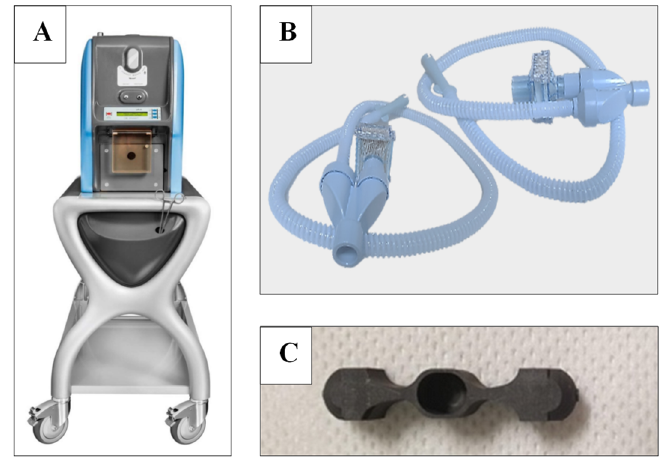
Figure 1. Photograph of ( A ) TechnegasPlus Technegas ® generator, ( B ) Cyclopharm Patient Admin- istration Set (PAS), and ( C ) Pulmotec ® empty crucible. (Courtesy of Cyclomedica.)